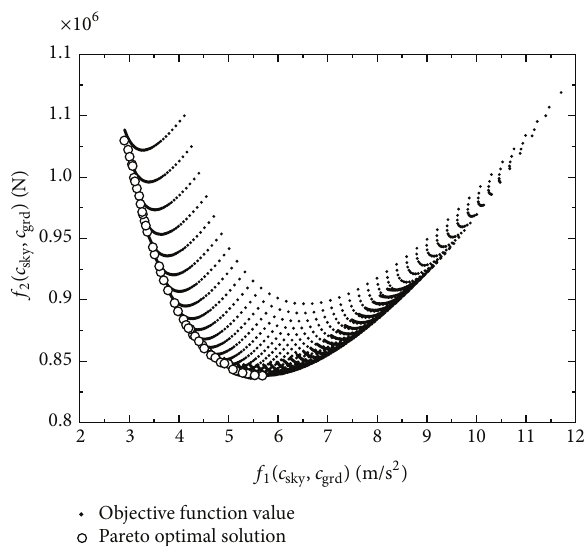
Figure3:ObjectivespaceandParetooptimalsolutionsforroadlevel D,